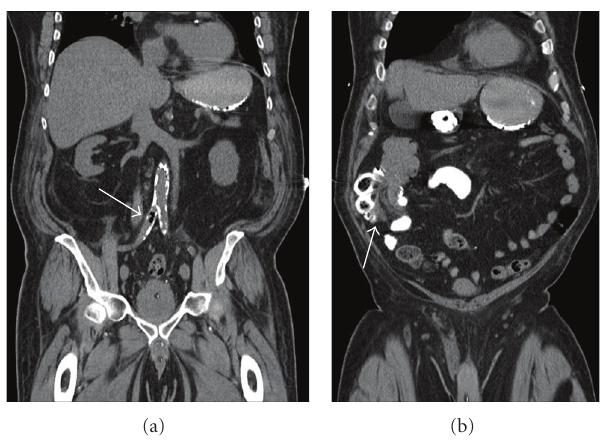
Figure 1: CT abdomen/pelvis (coronal): (a) multiple bubbles of gas within the lumen of the infrarenal aorta and right common iliac artery, consistent with bacterial aortitis and (b) ileo-colic intussusception caused by a cecal tubulovillous